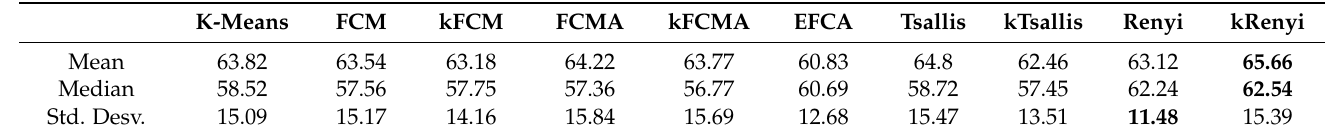
Table 4. Mean and median accuracy attained by each method on all datasets and related standard deviations. K-Means